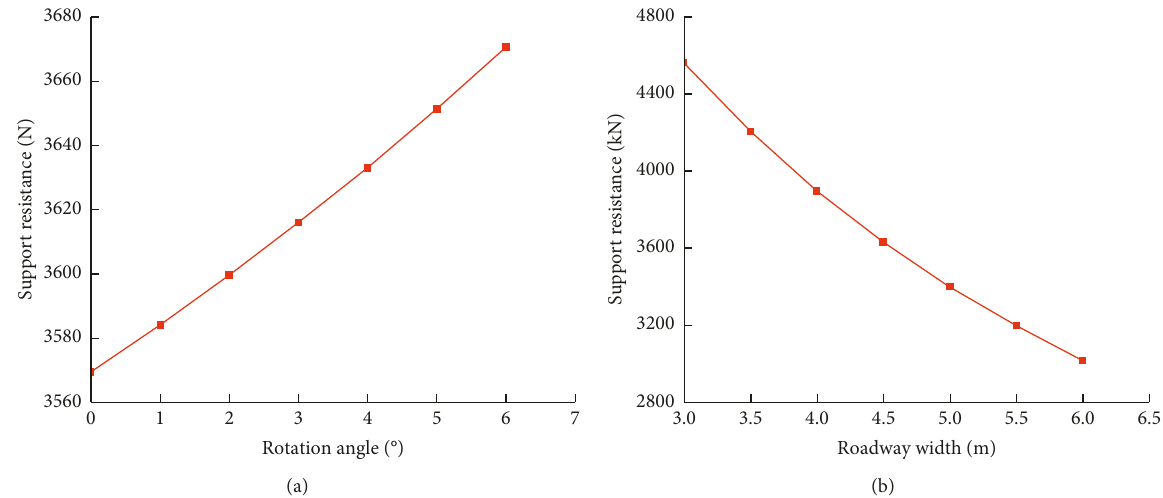
Figure 6: Relationship among (a) rotation angle of the key block and the wall force and (b) roadway width and wall